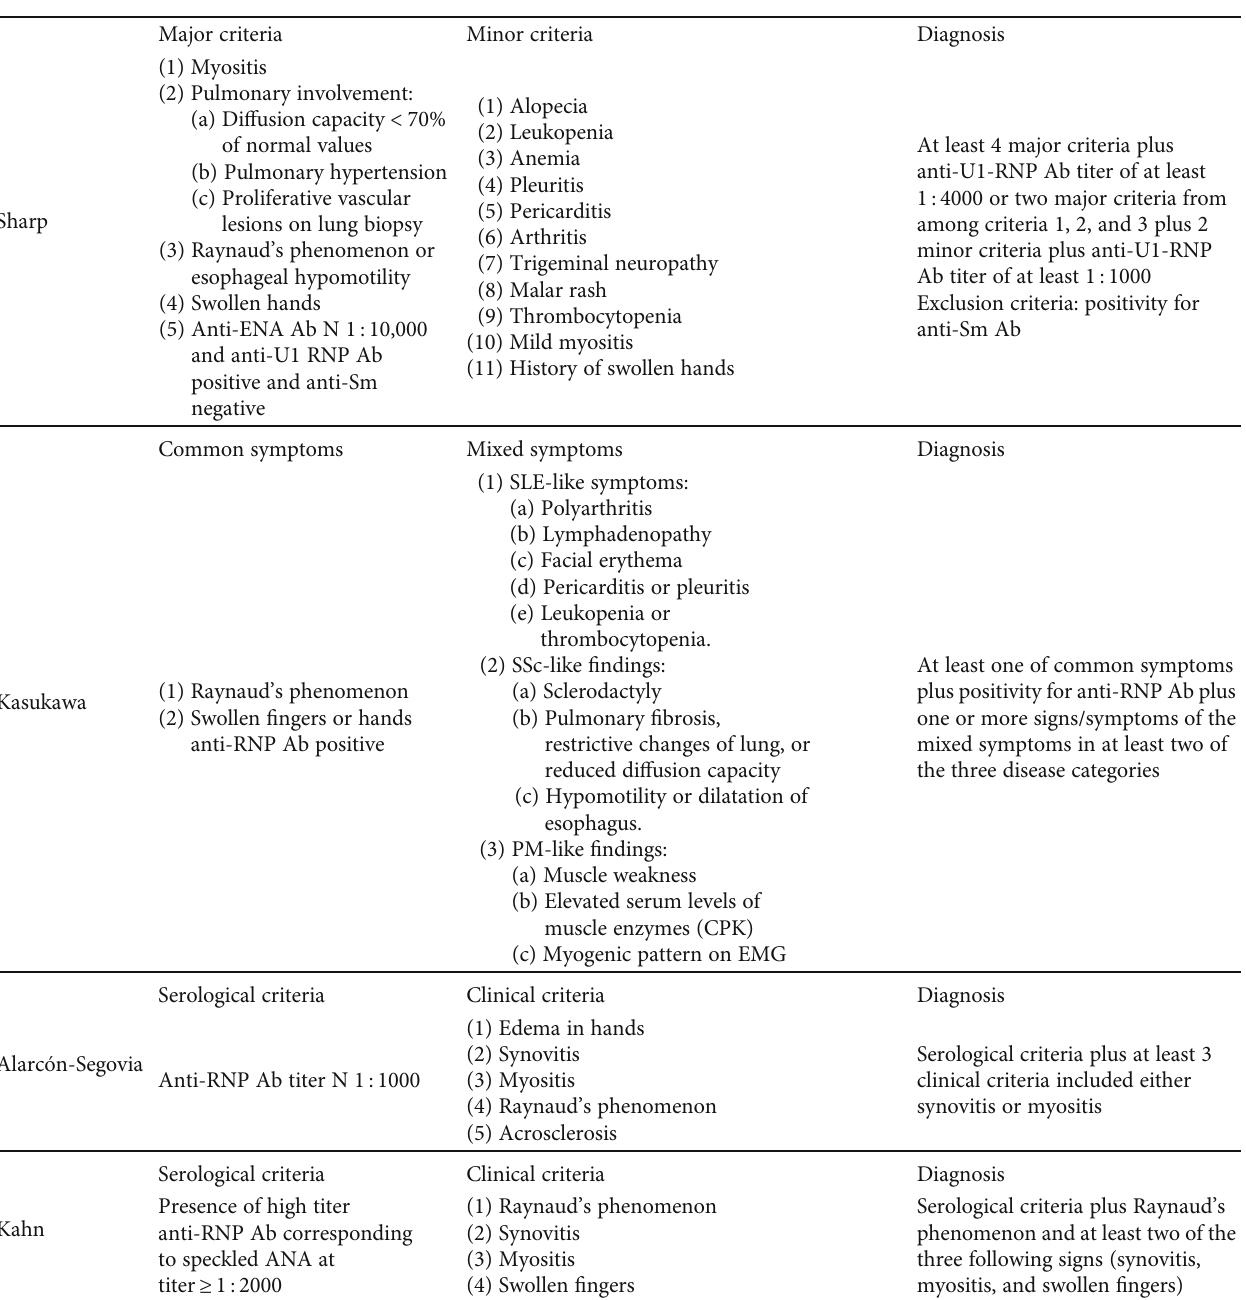
Table 1: Diagnostic criteria for mixed connective tissue disorder